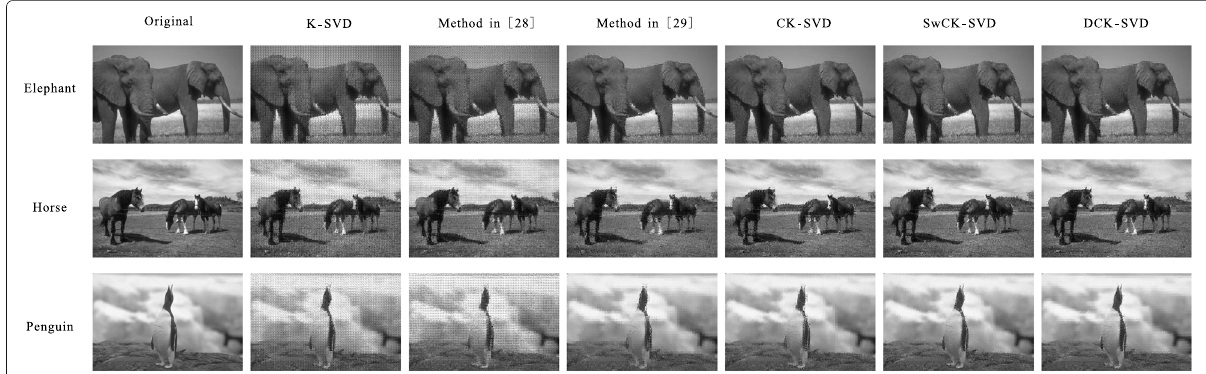
Fig. 8 Reconstructed images by using different dictionaries with the patch size of 8 × 8, m = 14